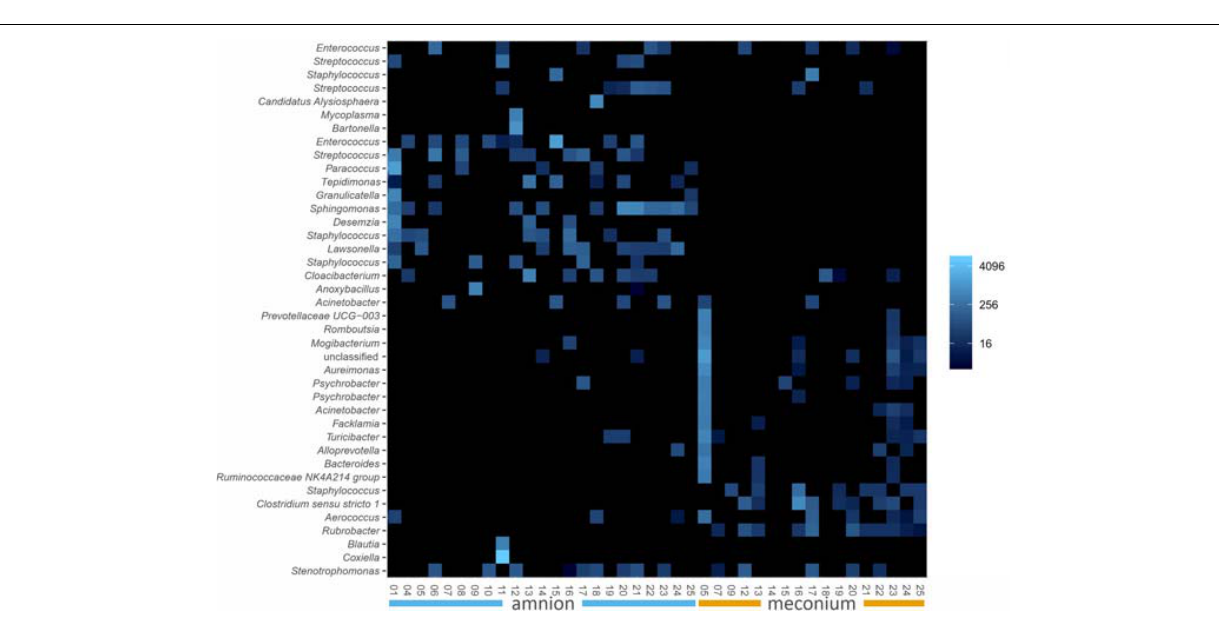
FIGURE 3 | Ecologically organized heatmap (NMDS, Bray) of the 40 most abundant ASVs in bovine meconium and amniotic fluid samples collected during elective C-section, sorted by sample type. The taxon names are presented as genus level identifications. Color scale indicates relative abundance and is a log transformation with base